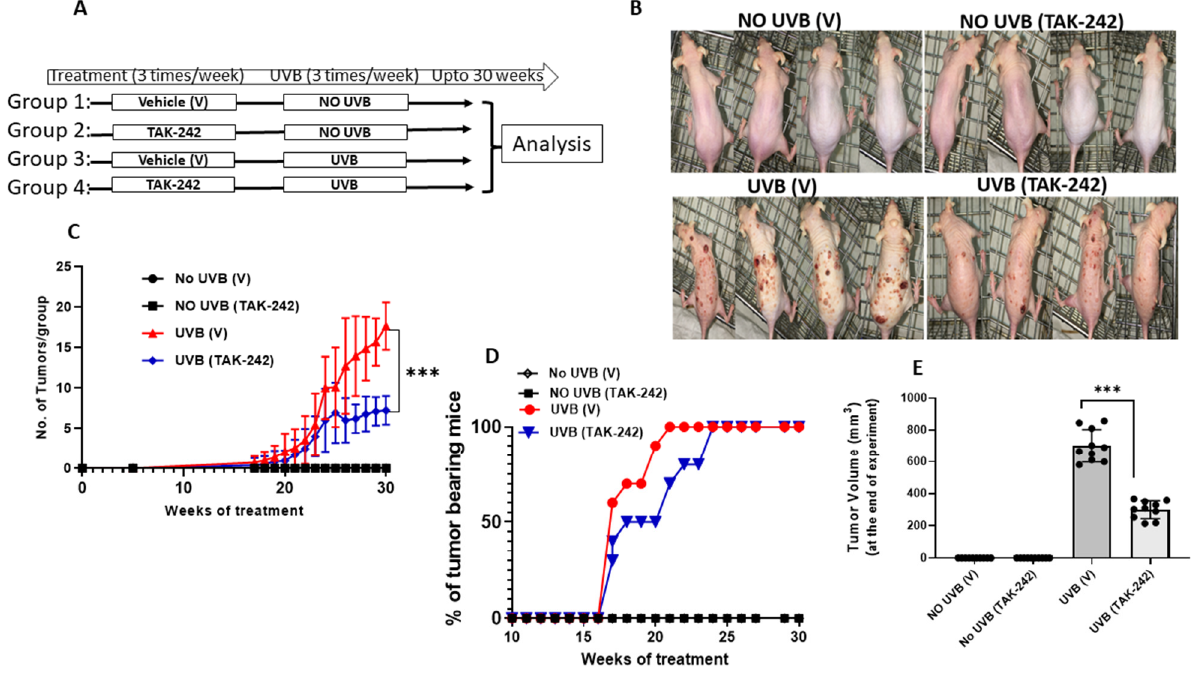
Figure 4. Topical treatment with TLR4 inhibitor TAK-242 blocks UVB-Induced tumorigenesis in mice. ( A ) Treatment scheme: The dorsal skin of panels of SKH-1 was treated with 0.5% TAK-242 (in acetone) or vehicle exposed to UVB radiation (180 mJ/cm 2 ), thrice a week up to 30 weeks.TAK-242 or vehicle was applied topically to the dorsal skin of SKH-1 mice 30 min before each exposure to UVB radiation. Tumor numbers were recorded weekly until the end of experiment at week 30. ( B ) Appearance of mice at termination of experiment; ( C ) number of tumors per group; ( D )percentages of tumor bearing mice; tumor volume at week 30 ( E ) At sacrifice, the TAK-242 treated group displayed a significant reduction in average tumor burden versus the vehicle control group. Experiments were conducted in 10 mice in each group. (*** p < 0.001).